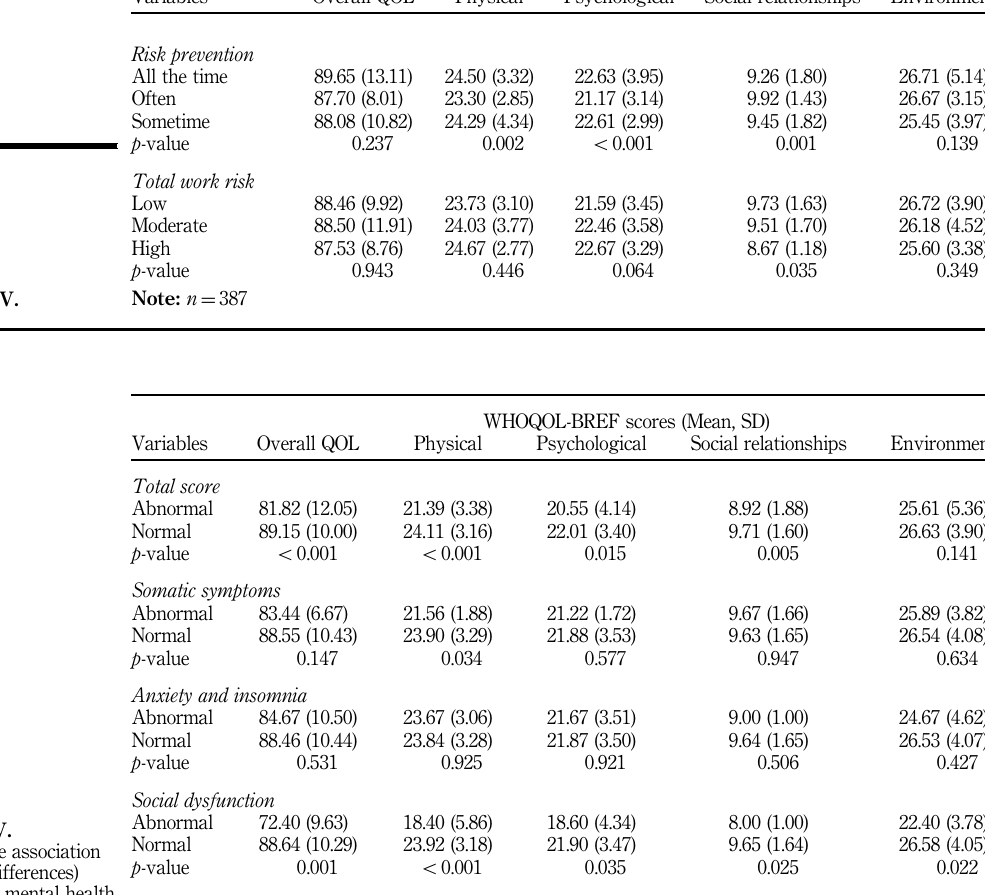
Table V. Bivariate association (mean differences) between mental health (GHQ) variables and quality of life (QOL) among older workers in community